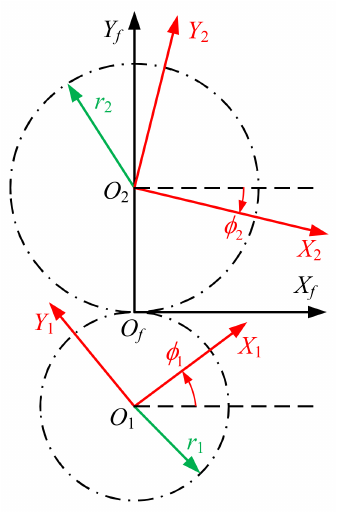
Figure 2. Coordinate systems of meshing